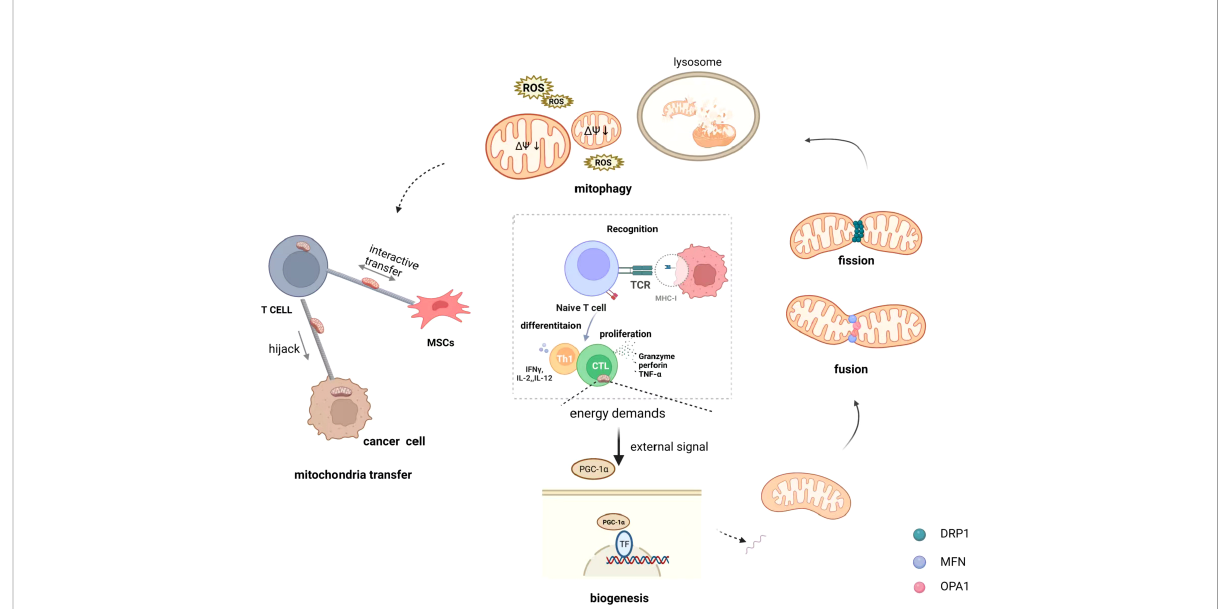
FIGURE 1 Mitochondrial quality control of T cells on immunometabolism. Immune cell differentiation and function are crucially dependent on speci fi c metabolic programs dictated by mitochondria and the speci fi c processes that occur in mitochondria are intimately linked to their